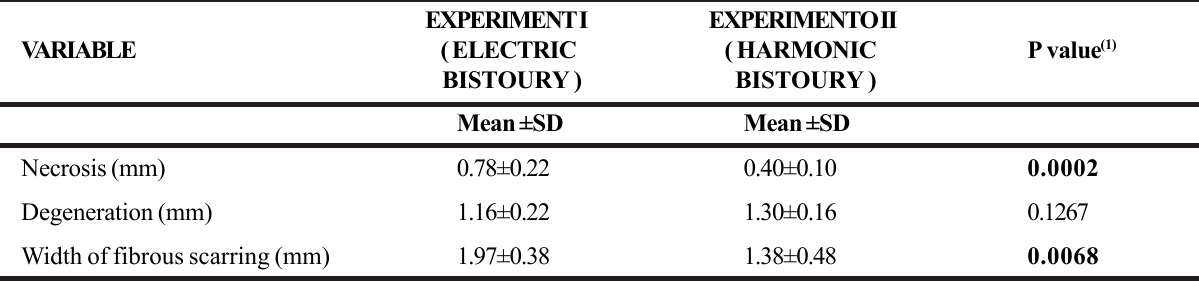
TABLE 1 - Results of means, standard deviations and p-values for the variables: necrosis, degeneration and width